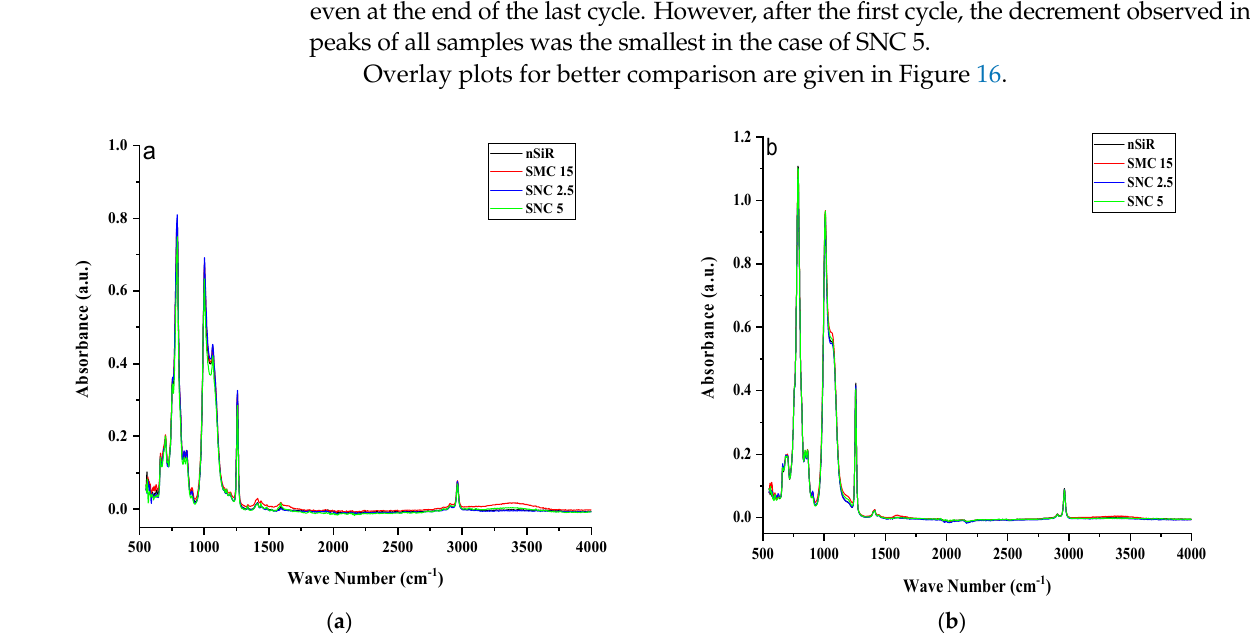
Figure 16 Overlay FTIR plots of samples ( a ) before aging and ( b ) after aging. Figure 16. Overlay FTIR plots of samples ( a ) before aging and ( b ) after aging. Table 3. Peak absorption of major groups in nSiR from virgin to 1000 h. Similarly, Si-O-C stretching (~1110–1050 cm − 1 ) and Si-O-Si asymmetric stretching (~1130–1000 cm − 1 ) showed a mostly similar trend for all the samples. Decrement and recovery in these peaks were found for all samples, but it is noteworthy that decrement was the smallest in the case of SNC 5. Therefore, it can be deduced from the above discussion that the inclusion of 5 wt% of nanosilica increased the stability of functional groups, as shown in Table